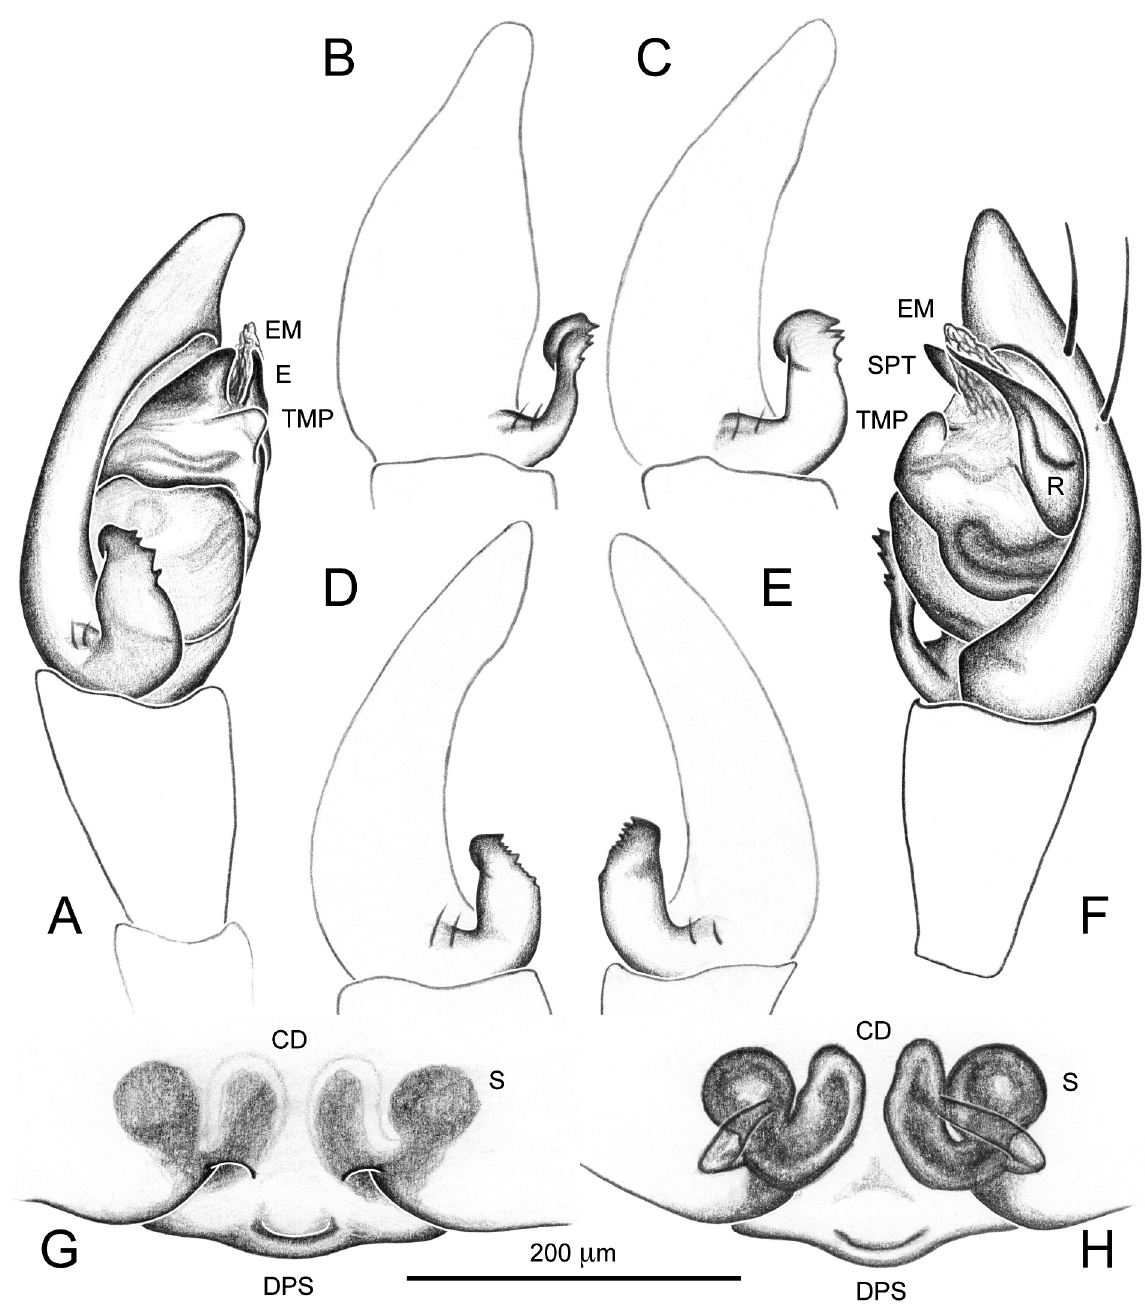
Fig. 13. Afroneta sarahae sp. nov. A–F . Holotype, ♂ (ZMUN 24056). A . Palp, retrolateral. B . Para- cymbium different angle, retrolateral. C . Palp, paracymbium different angle, retrolateral. D . Right palp specimen 2, paracymbium, retrolateral. E . Left palp specimen 2, paracymbium, retrolateral. F . Palp, prolateral. G–H . Allotype, ♀ (ZMUN 24056). G . Epigyne, ventral. H . Vulva, dorsal. Scale bar: 200